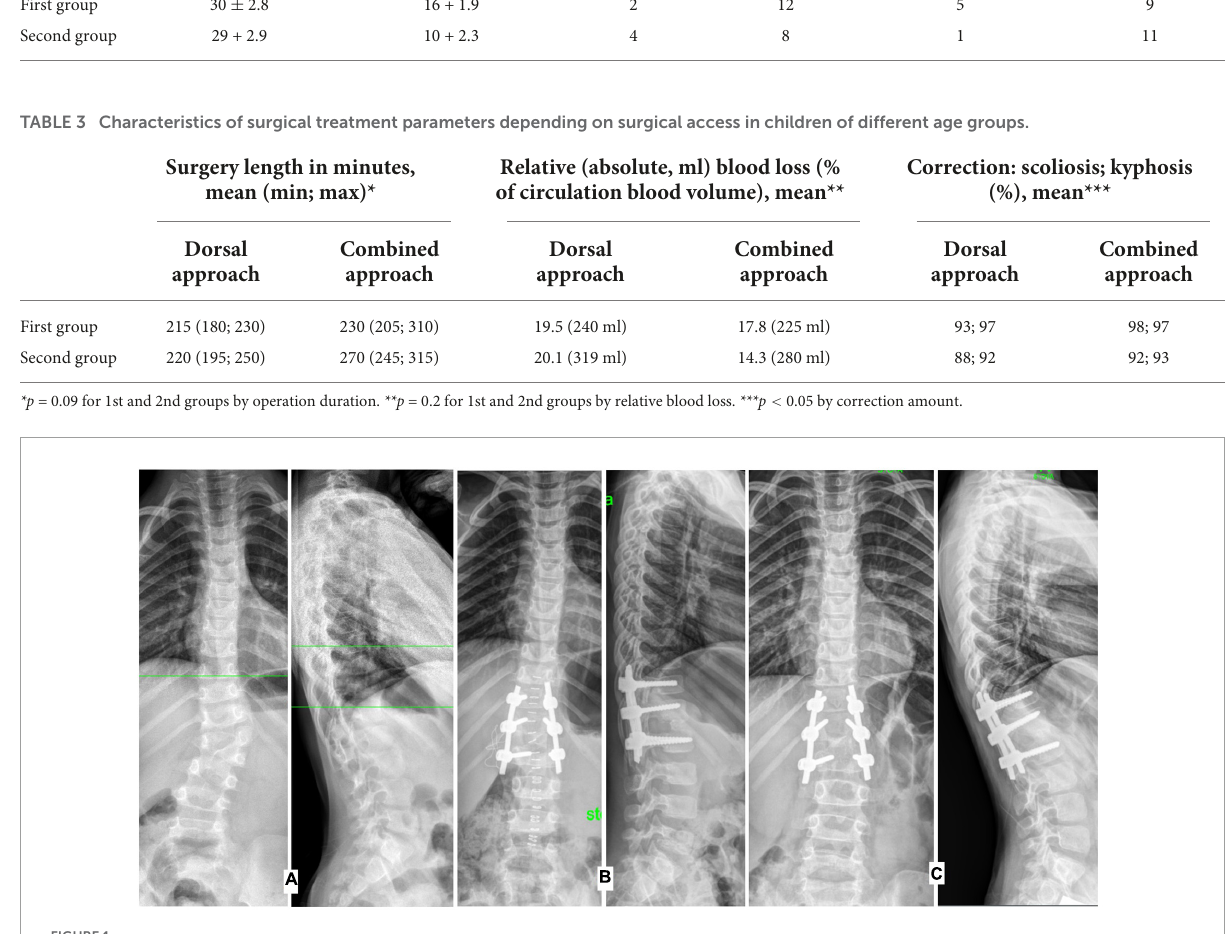
FIGURE1 Radiographs of the spine in the frontal and lateral projections, operated at the age of 3 years 6 months: (A) before surgical treatment, (B) on the 6th day after surgical treatment, (C) 3 years after correction of congenital spinal deformity.